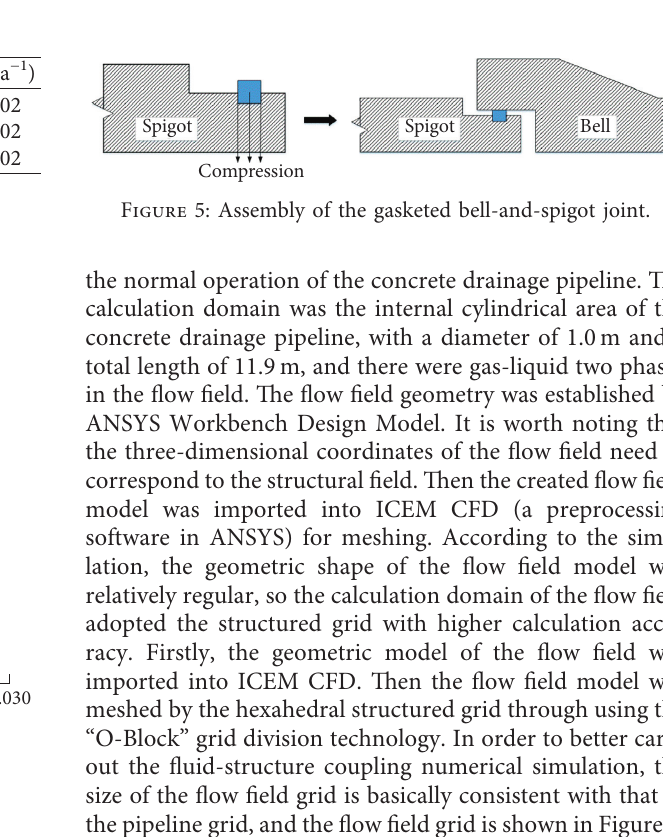
Figure 3: The amplitude of impulse